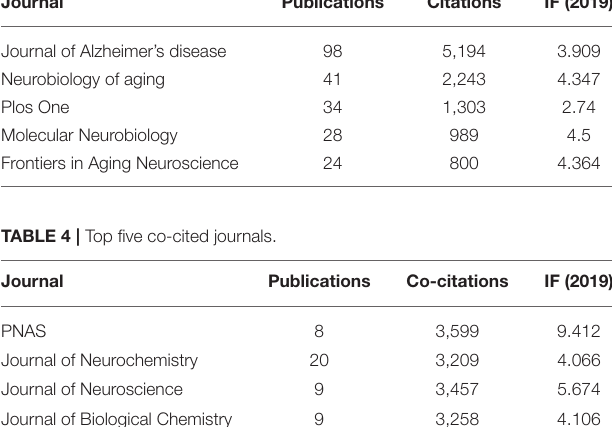
the centrality of each circle. The thicker the purple ring, the higher its centrality. The red ring represents a burst in a certain year. The line between the two circles represents the cooperative relationship between the two countries. The color of the line represents the closeness of the cooperation. The yellower the color, the closer the